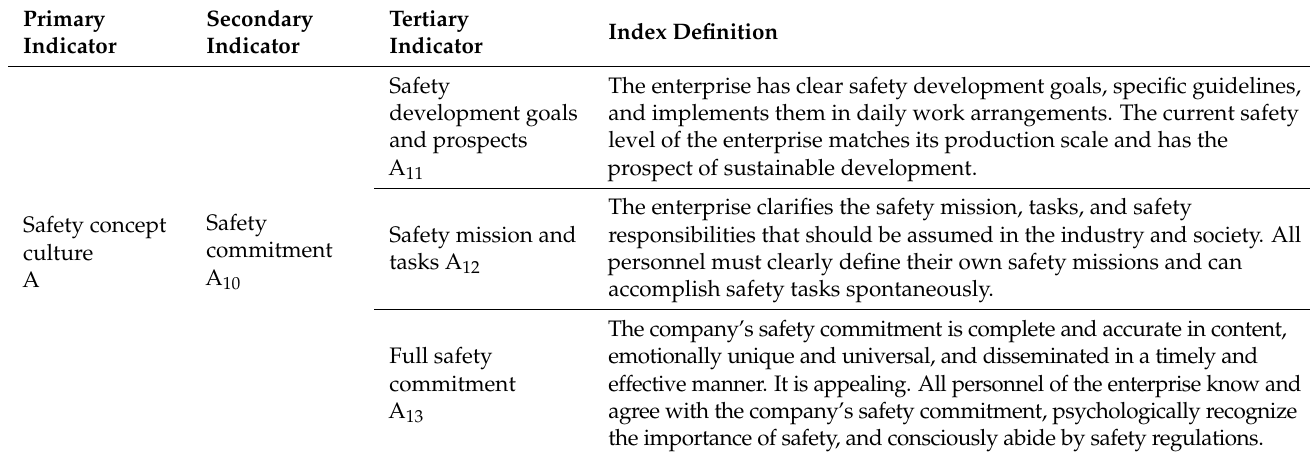
Table 1. Index System of Safety Culture Maturity